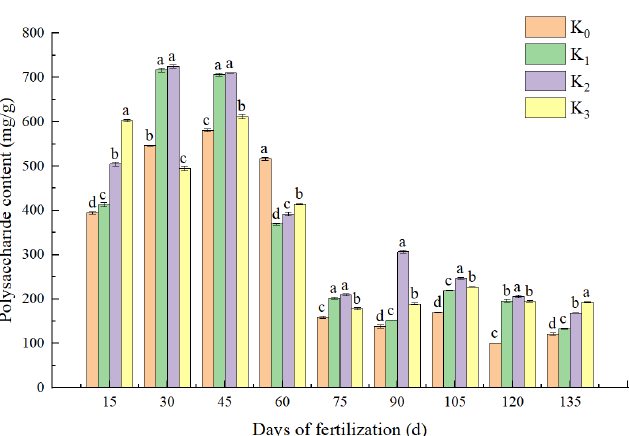
Figure 1. Effects of potassium application on polysaccharide contents of L. davidii var. unicolor bulbs. The same letter indicates no significance between treatments, and different letters indicate significance, K concentrations comprising K 0 (0 mg ∙ L − 1 ), K 1 (447.6 mg ∙ L − 1 ), K 2 (671.4 mg ∙ L − 1 ), or K 3 (895.2 mg ∙ L − 1 ). Samples were taken every 15 days after potassium application.